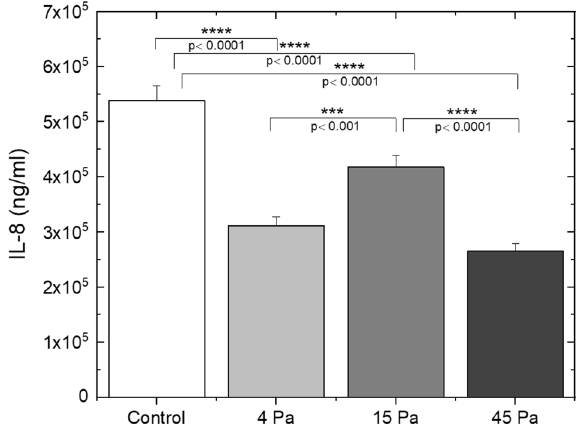
Figure 5. Various shear stress forces downregulate IL-8 secretion from THP-1 cells. THP-1 cells were treated with 4 Pa, 15 Pa, or 45 Pa shear stress for 3 h. IL-8 levels were measured by ELISA. Bar graph represents the mean IL-8 concentration of four independent experiments. p values determined by ANOVA (±